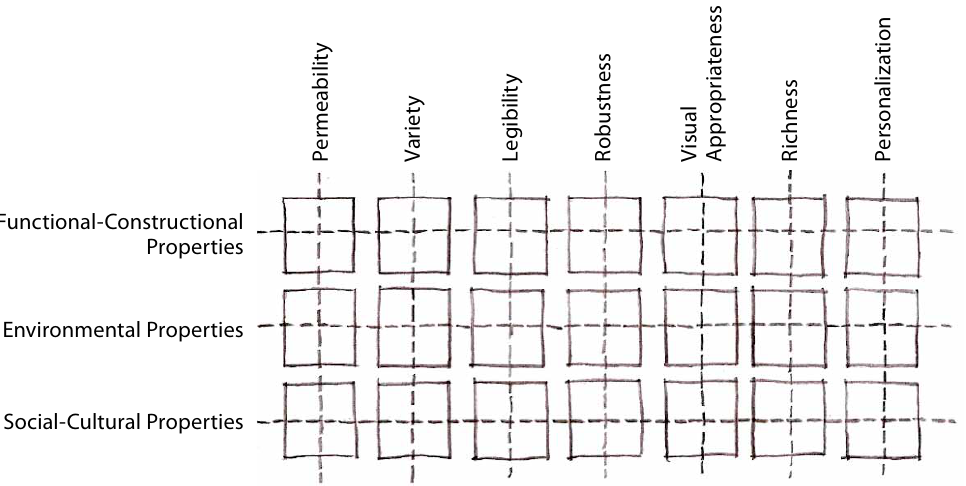
fig. 1. The paper’s structure according to functional-constructional, environmental and social-cultural properties (described in three rows) of the TPH and their analysis according to responsiveness criteria (described in seven